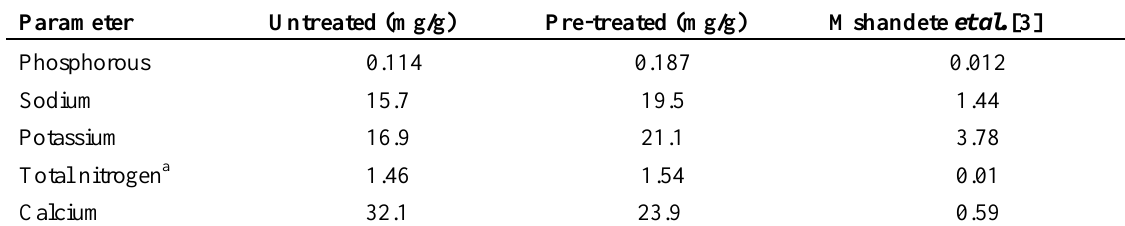
Table 2. Comparison of biogas manure after AD of untreated SLDR and that pre-treated with 10% of CCHT-1 followed by 25% T. reesei inoculum, with that reported by Mshandete et al. [22]. ( a% of dry